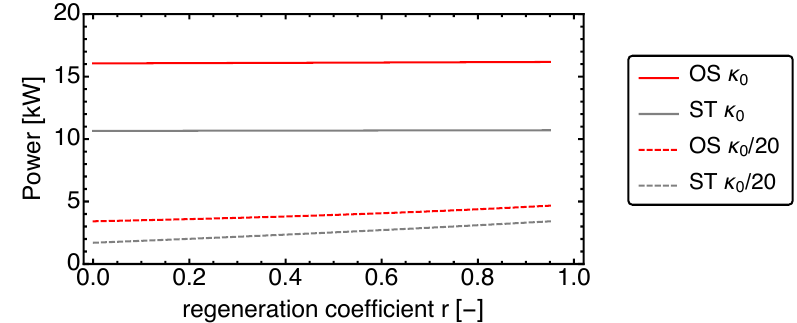
Figure 4. The power output is shown as a function of the regeneration coefficient r for the reference case in comparison with the low mass transfer case . For both, the power output is nearly unaffected by the extent of the regeneration independent of the used motion.